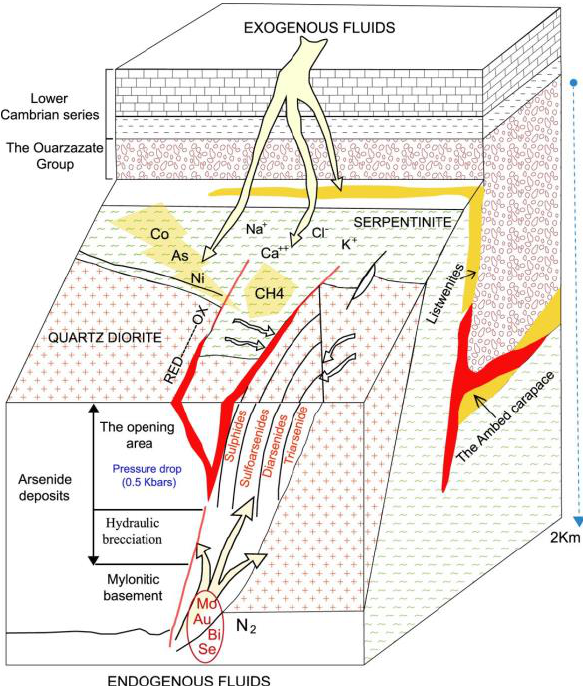
Figure 6. Proposed genetic model of the Bou Azzer Co–Ni deposits modified by [47] after [35].